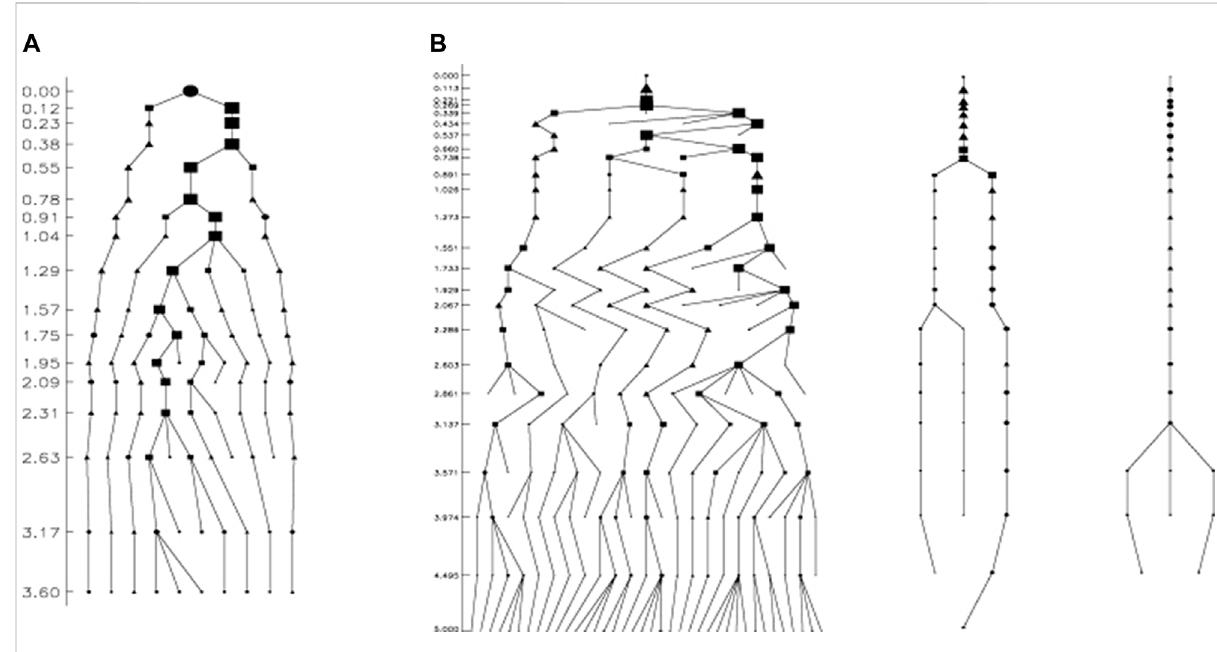
FIGURE 8 (A) : family tree of the BCG galaxy in a low-resolution simulation. (B) : family trees of the BCG galaxy, the third most massive galaxy and a lower mass galaxy in the high-resolution re-simulation of the same cluster. The size of symbols is proportional to the logarithm of the mass of the galaxies atthecorrespondingredshift.Shown onthevertical axis ontheleft-handsideare theoutputredshiftsused to reconstruct thefamily trees; these are differentinbothsimulations.Agalaxyinthesetreesisconsideredaprogenitorofanothergalaxyifatleast50percentofitsstarsareboundtoits daughtergalaxy,accordingtotheSKID algorithm. Manymoregalaxiescanbeidenti fi edinthehigh-resolution simulationatsimilarredshift.TheBCG family tree is characterized by one dominant branch with a number of other branches merging into it, at both resolutions. Squares and triangles are assignedaccordingtotheclassi fi ed ‘ merging ’ or “ stripping ” events.CirclescorrespondtoredshiftatwhichthegalaxyisnotreleasingstarstotheDSC. Image reproduced from Figure 3 of Murante et al. (2007) with the permission.